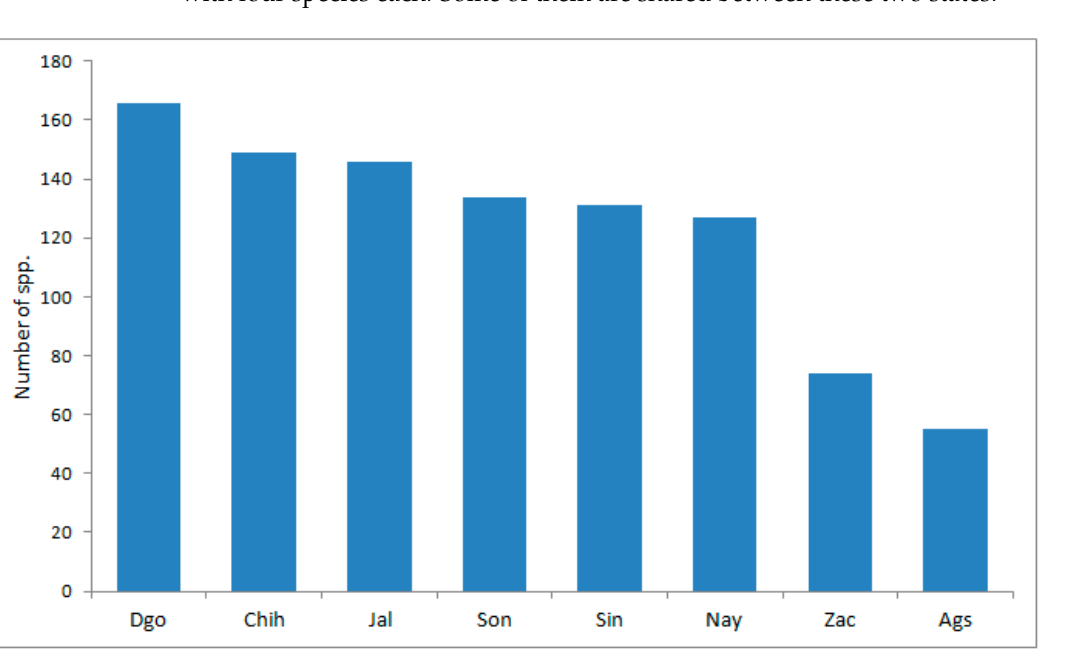
Figure 3. Species diversity in the Mexican states. The abbreviations are: Ags = Aguascalientes, Chih = Chihuahua, Dgo = Durango, Jal = Jalisco, Nayarit = Nay, Sin = Sinaloa, Son = Sonora, Zac = Zacatecas.